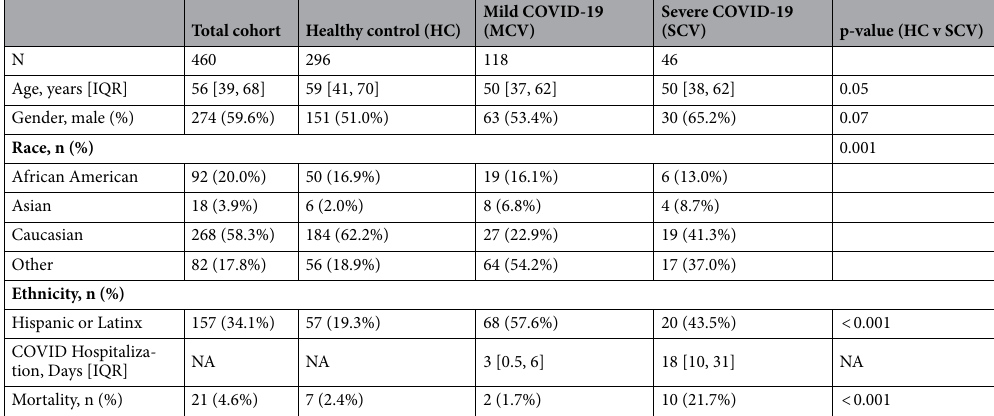
Table 1. Training cohort (GSE167202) demographics. p-values were calculated using Mann–Whitney U Test and